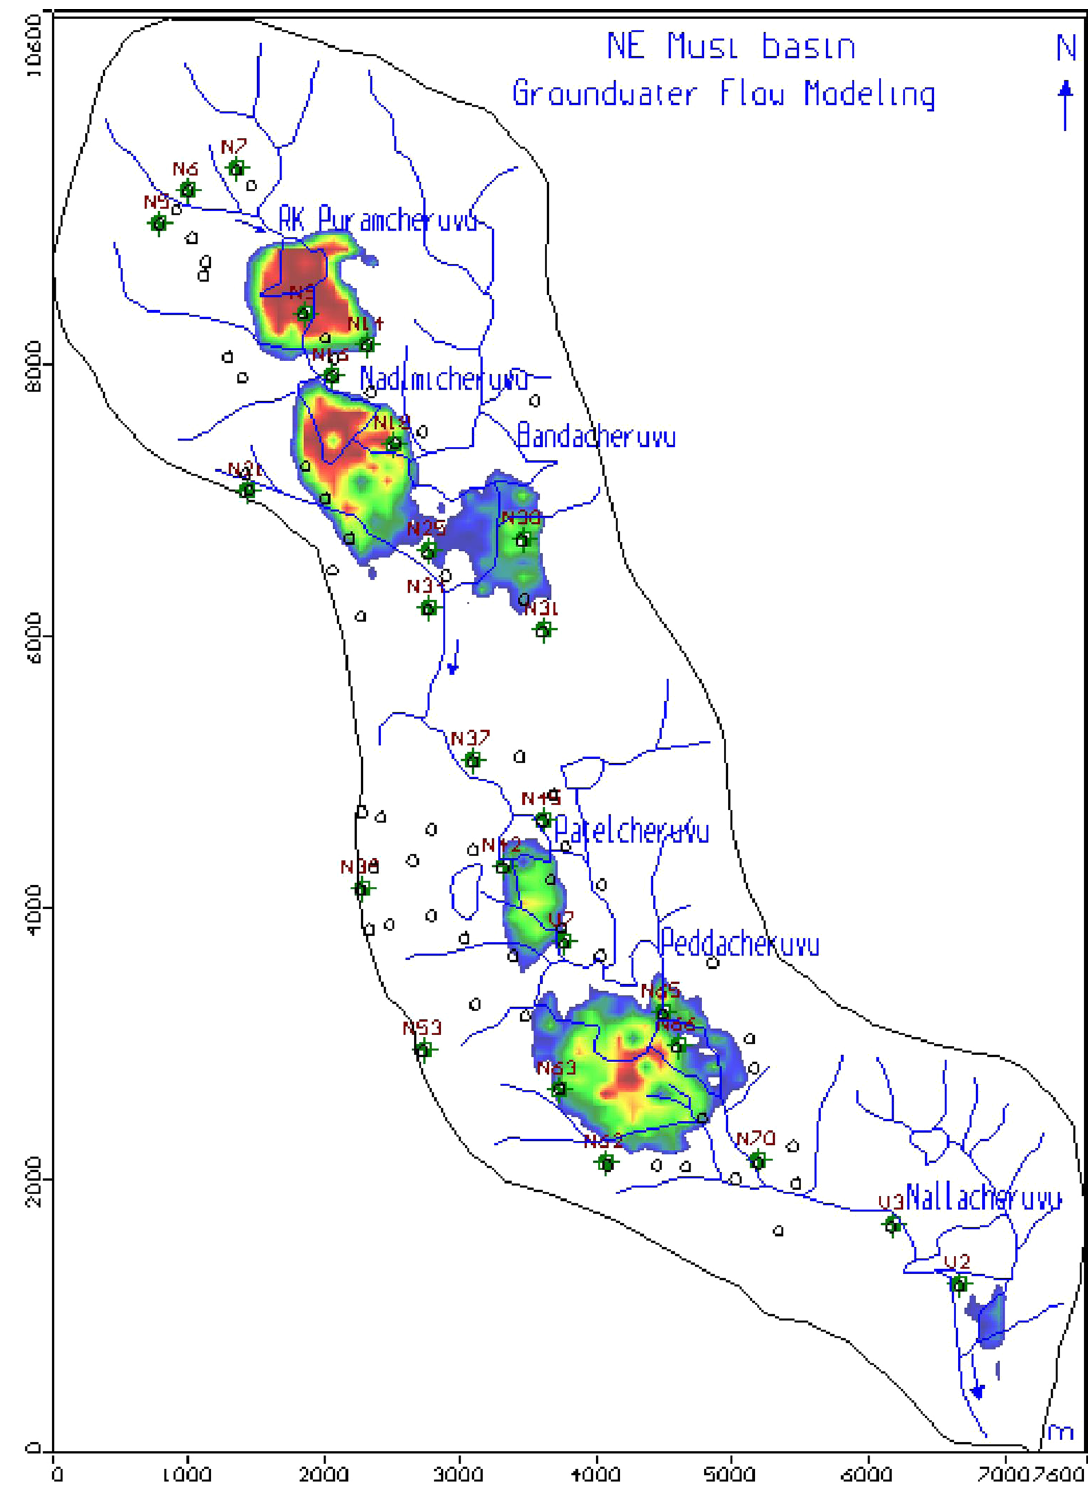
Fig. 11 TDS concentration of second layer in and around the lake for